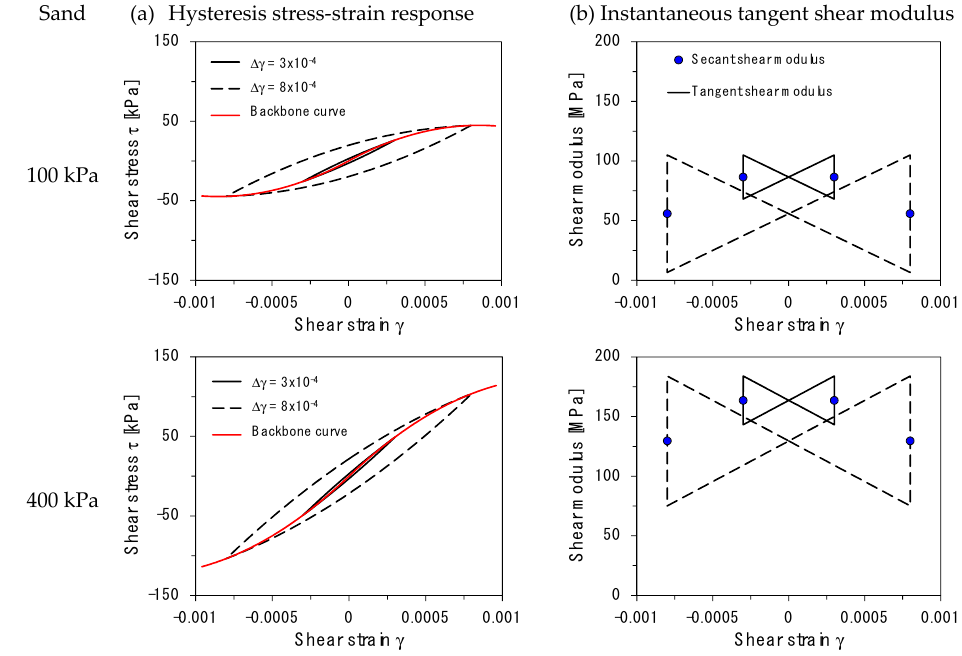
Figure 5. Strain-dependent dynamic response of sand under two different confinement stress levels. ( a ) Hysteresis shear stress–strain relation; ( b ) instantaneous tangent shear